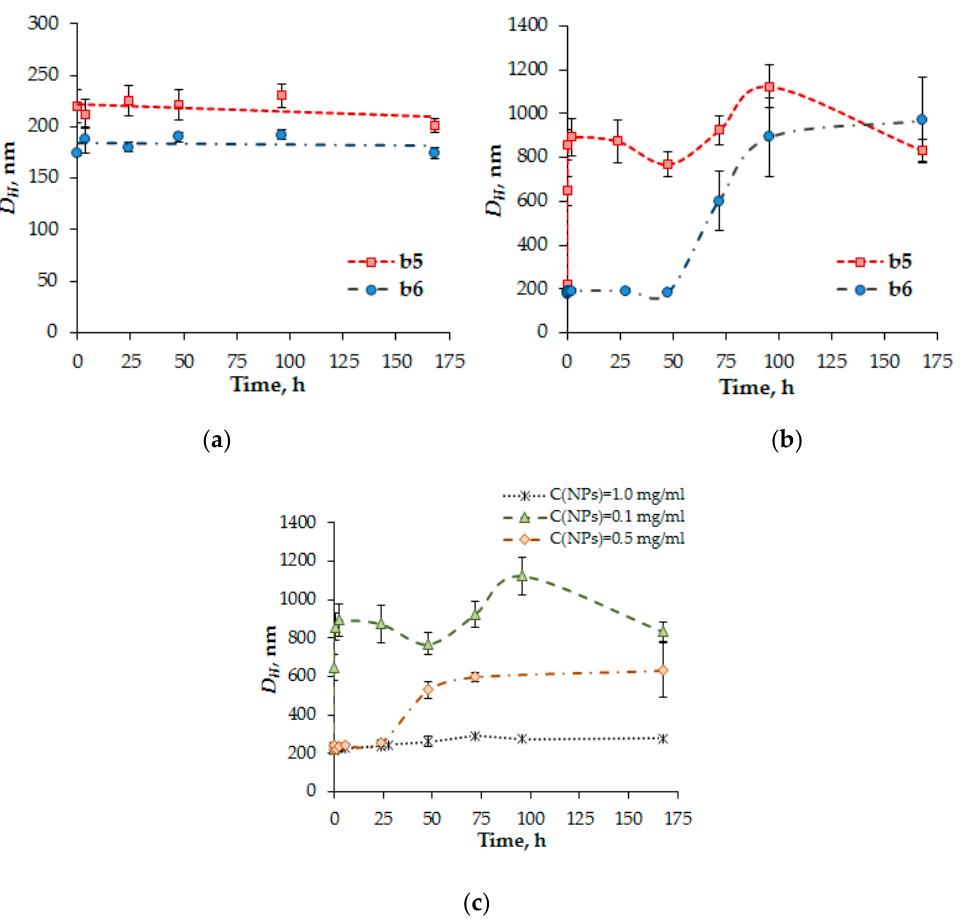
Figure 10. The kinetics of the glutathione-mediated NPs disruption induced by reduction of disulfide bonds of PMAG -b -PGlu(OBzl). Reaction conditions: ( a ) C NPs = 0.1 mg/mL, C GSH = 2 μ M; ( b ) C NPs = 0.1 mg/mL, C GSH = 10 mM; ( c ) C GSH = 10 mM.